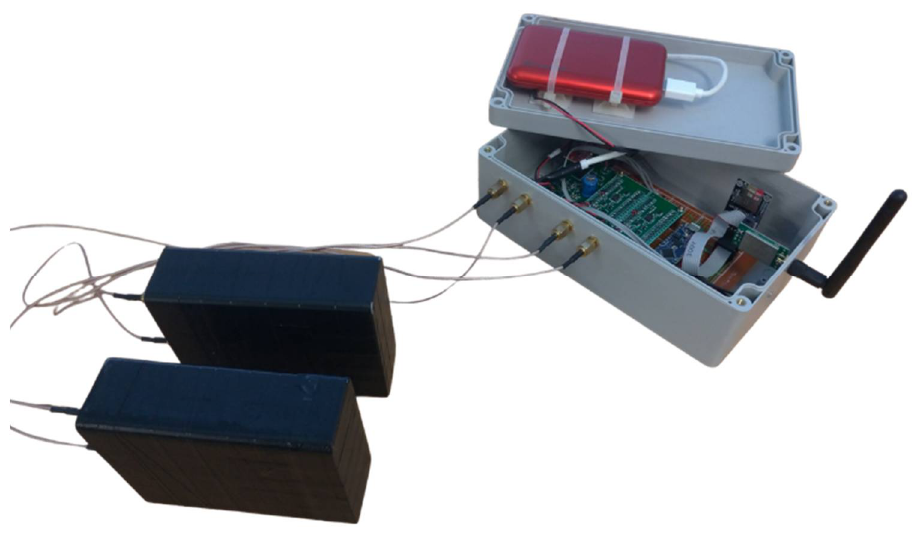
Figure 5. The detection system consisting of two detection modules connected to the data acquisition and management module.